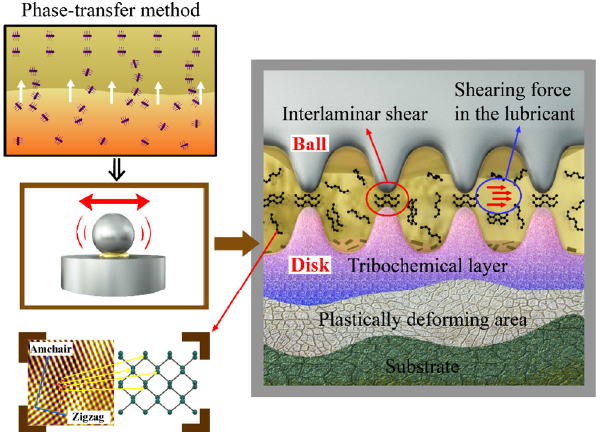
Fig. 29 Schematic diagram of lubrication mechanism of black phosphorus as lubrication additive.